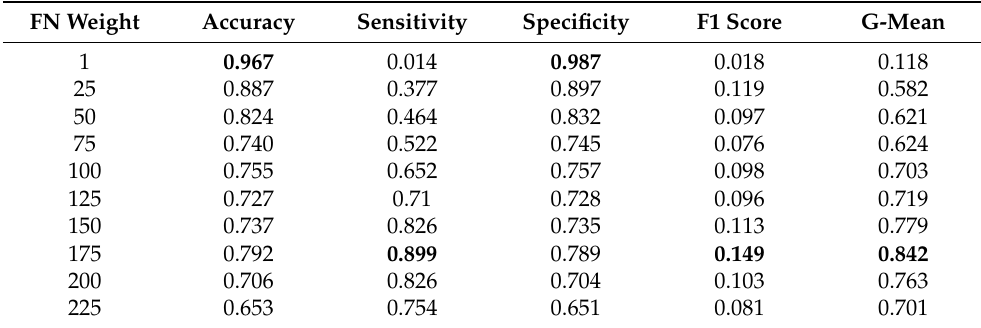
Table 6. The effects of the weight of false negative predictions on all metrics using the PSO (for the dataset of Polish companies). The best result for each metric is marked in boldface.